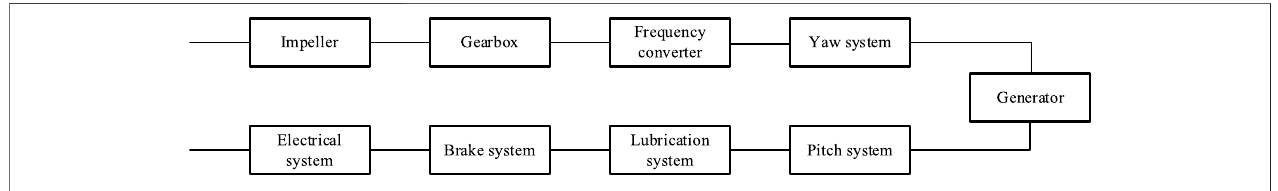
FIGURE 2 | Reliability block diagram of the wind